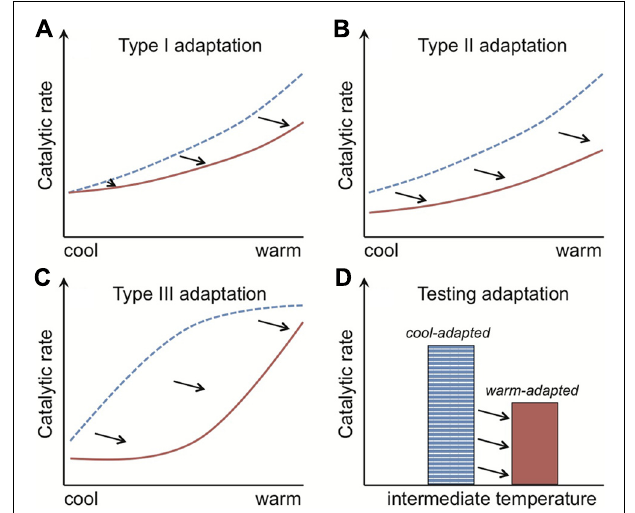
FIGURE 3 |The rate of enzyme-mediated reactions are shifted right along the temperature axis for organisms adapted to warmer conditions. The catalytic rates of both cool- and warm-adapted enzymes (blue dotted and red solid lines, respectively) increase with temperature. Their temperature response pattern, however, differs.With type I adaptation (A) the temperature sensitivity (i.e., Q 10 ) of warm-adapted enzymes is lower, and with type II adaptation (B) this sensitivity is unchanged but the absolute catalytic rates are consistently lower across the temperature gradient.Type III adaptation (C) represents a mix of type I and II adaptation and is associated with shifts from cold- to warm-adapted communities, where adaptation leads to separation of the temperature response into discrete, bell-shaped curves (see Figure 5 ).The commonality in pattern across the type I to III responses is that the temperature optima of warm-adapted enzymes, individuals, populations or communities is shifted right of the cold-adapted lines.The black arrows depict this “right shift.”The classical test for thermal adaptation (D) involves measuring process rates at an intermediate temperature (i.e., between cool and warm), where types I–III adaptation would always produce lower rates for the warm-adapted communities, assuming variables such as substrate supply are non-limiting and rates are standardized by organism